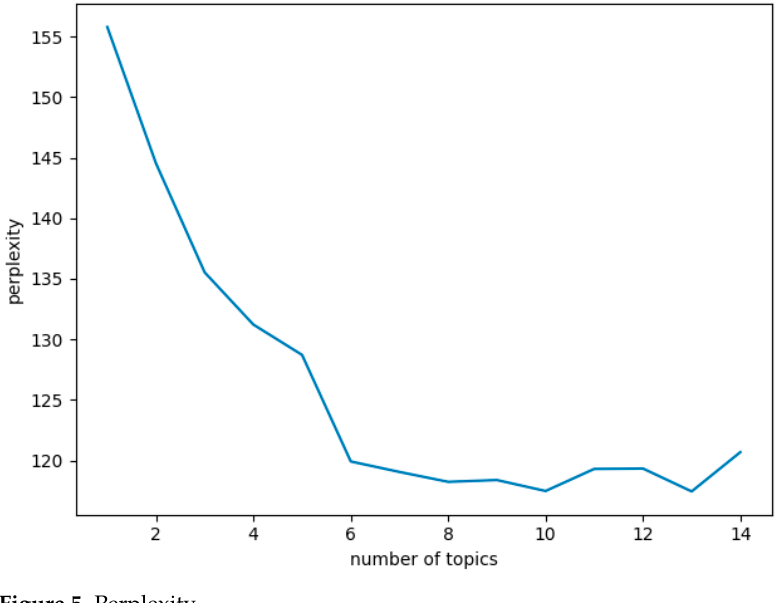
Figure 5. Figure 5. Perplexity.